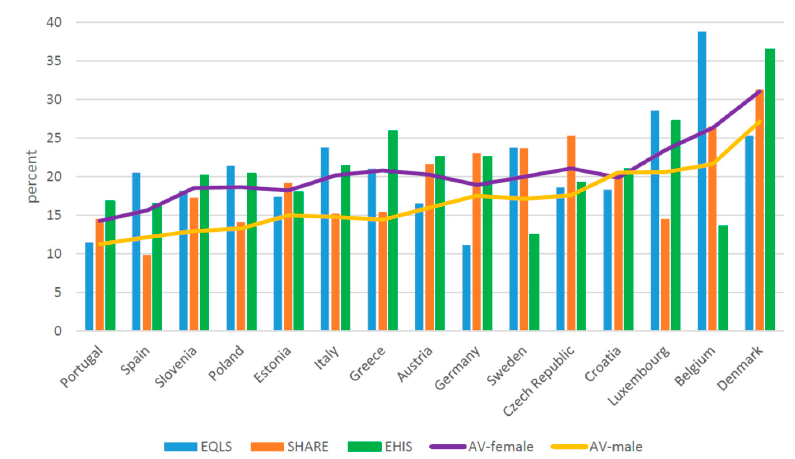
Figure 3. Informal Caregivers over 50 among females (weighted) (percent). EQLS = European Quality of Life Survey; SHARE = Survey of Health, Ageing and Retirement in Europe; EHIS = European Health Interview Survey; AV=Average. Table 3. Informal Caregivers over 50, by gender (weighted).